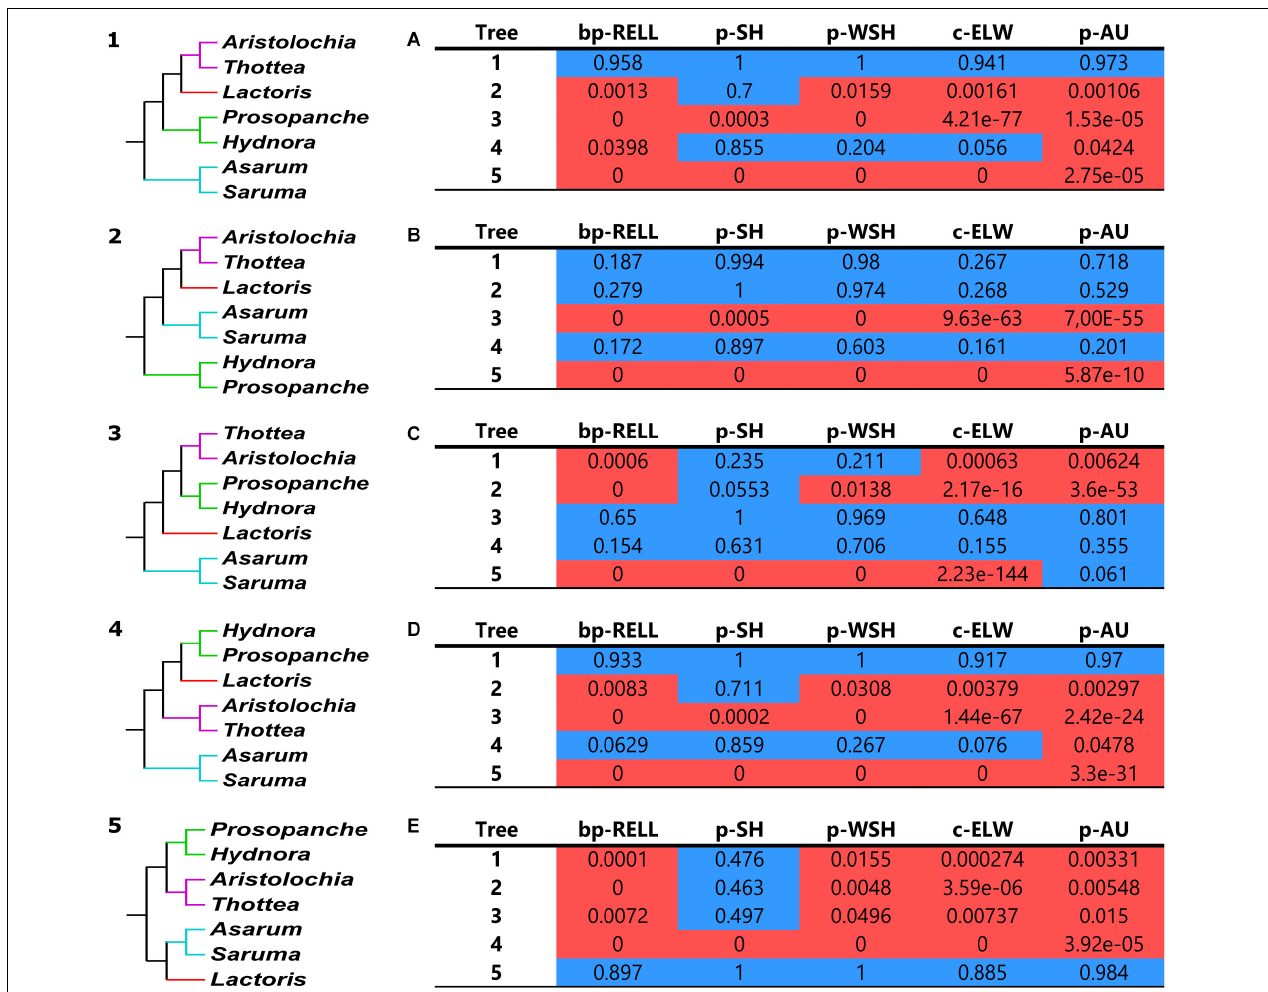
FIGURE 4 | Topology test results for recovered topologies. Shown are the tested topologies (1–5) and tables (A–E) containing results of the bp-RELL, p-SH, p-WSH, c-ELW, and p-AU analyses. Tree numbers in the tables correspond to the topologies on the left (1–5) . Topology (1) contains clade II and was recovered for the concatenated three-genome data set (ML, genome partition), topology (2) was inferred for the 83 gene plastid data set (ML, assigning each 3rd codon position its own partition). Topology (3) , containing clade III, was reconstructed using the 44 gene mitochondrial data set (ML, gene partition), topology (4) using the concatenated 137-loci data set (MP, single partition), and topology (5) using the concatenated nuclear loci (ML, single partition). Table (A) shows the topology test results with topology (1) as null hypothesis, table (B) with topology (2) as null hypothesis and so on. Blue-colored values denote results within the 95% confidence sets; red-colored values denote significant exclusion. In the topologies (1–5) , perianth-bearing Piperales are color-coded: Asaraceae in turquoise, Aristolochiaceae in purple, Lactoridaceae in red and Hydnoraceae in